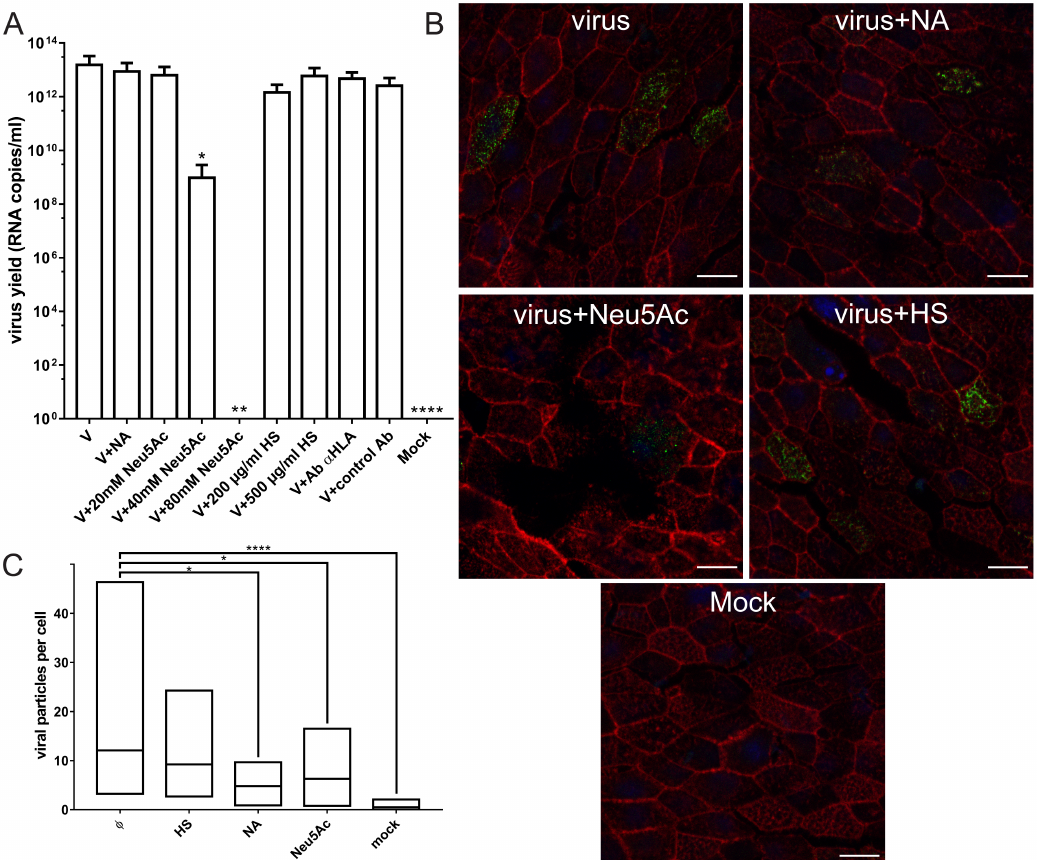
Figure 12. Attachment and replication of HCoV-OC43 0500 in human airway epithelium (HAE) cultures. ( A ) SAs serve as entry receptors for HCoV-OC43 0500. Influence of NA (200 mU/mL), HS (200 µ g/mL), Neu5Ac (20–80 mM), and HLA class I specific antibodies (0.5 µ g/mL) on HCoV-OC43 0500 infection. Viral yield was assessed by RT-qPCR 5 days p.i. The data is presented as mean ± SD from at least two experiments in duplicates. (* p < 0.05; ** p < 0.01; *** p < 0.001; **** p < 0.0001). ( B ) SAs serve as attachment receptors for HCoV-OC43 0500. Confocal analysis of NA (200 mU/mL), Neu5Ac (40–80 mM) and HS (200 µ g/mL) effect on HCoV-OC43 0500 attachment. Viral capsids are presented in green, blue denotes DNA and red represents actin. Scale bar 10 µ m. ( C ) Quantification of virus attachment. A number of viral particles that attached to the surface of fully differentiated HAE culture was graphed. Data were collected from a minimum of 12 fields of view, from at least two different samples. Number of particles and number of cells were quantified using ImageJ Fiji built in tool “3D Objects Counter”. Results are presented as min-max graph with line corresponding to the mean value (* p < 0.05; ** p < 0.01; *** p < 0.001; **** p <